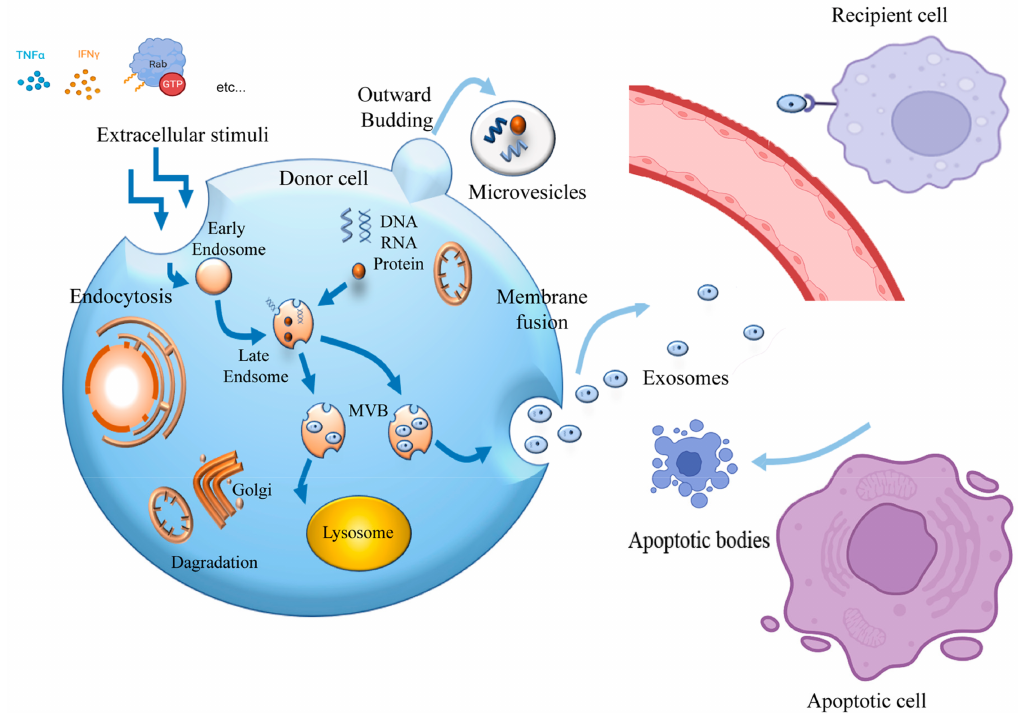
Figure 3. Biogenesis and information exchange of exosomes. The invagination of the plasma membrane forms a cup-shaped structure, which includes proteins on the cell surface and some components in the extracellular environment, such as proteins, lipids and metabolites, making up the early endosomes. Early endosomes then develop into late endosomes and invaginate to form intraluminal vesicles, and the cytoplasmic components also enter intraluminal vesicles, and then, late endosomes form multivesicular body. Finally, multivesicular body fuses with the plasma membrane and the exosomes are released. The receptor cells mainly interact with the exosomes through three ways: (1) the exosomes bind to the receptors on the cell membrane; (2) the exosomes fuse directly with the cell membrane to release the contents; (3) the exosomes directly enter the cytoplasm in a complete form through cellular pinocytosis or